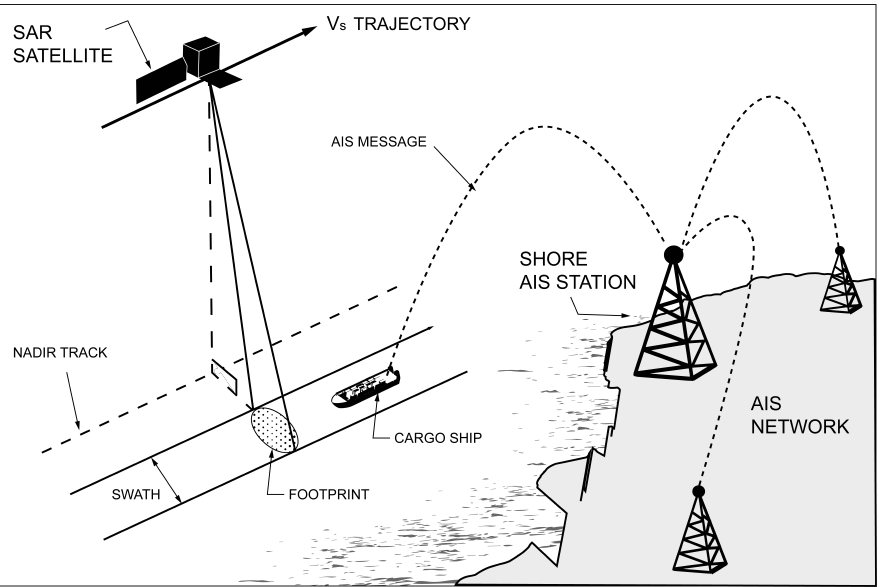
Figure 1. Pictorial view of a spaceborne SAR gathering an image over a coastal